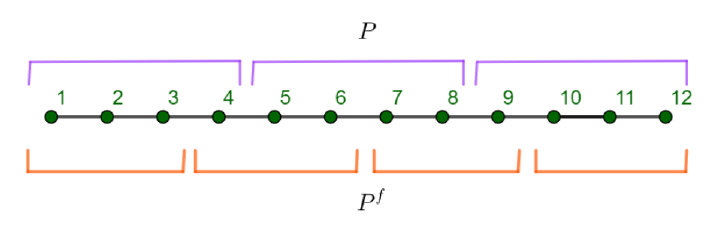
Figure 3. Chain with 12 nodes. Partitions P and P f